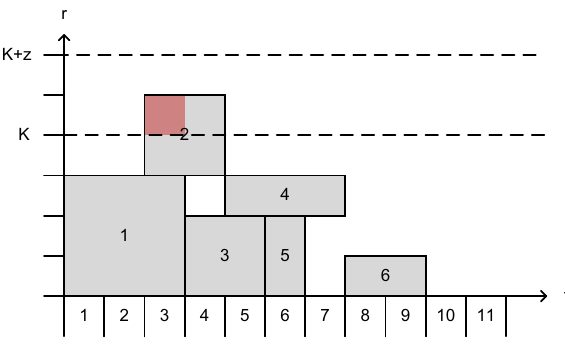
Fig. 4 Schedule with some overtime